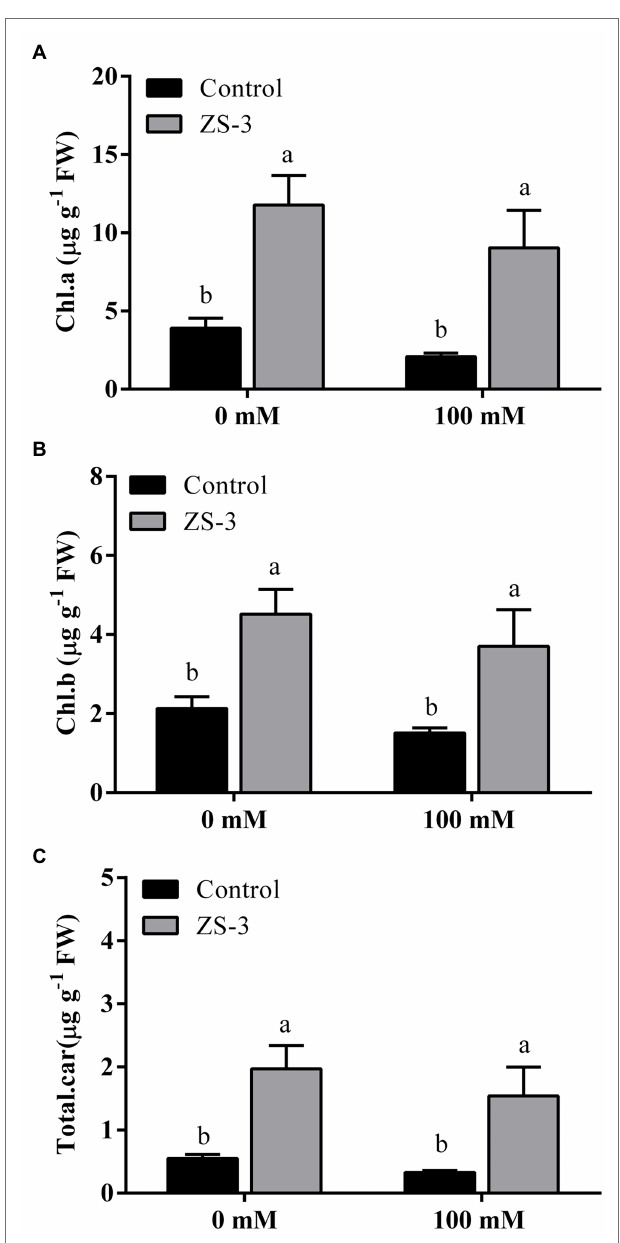
FIGURE 2 | Effect of inoculation with ZS-3 on chlorophyll a (A) , chlorophyll b (B) and carotenoid (C) contents in Arabidopsis thaliana . The results are the mean ± standard deviation from three independent experiments. Different lowercase letters above the bars represent significant differences based on one-way ANOVA (Duncan’s multiple range, p <